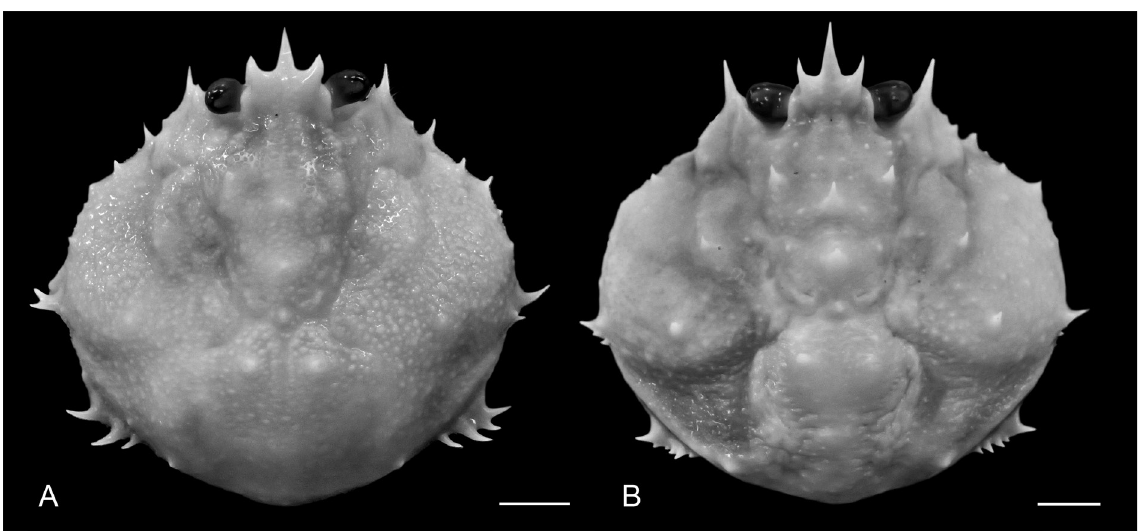
Fig. 16. Platymaia remifera Rathbun, 1916, overall dorsal view. A . Ovigerous ♀ (29.2 × 31.3 mm) (ZRC 2016.0089), South China Sea. B . ♂ (33.0 × 36.9 mm) (ZRC 1999.0769), Taiwan. Scale bars =